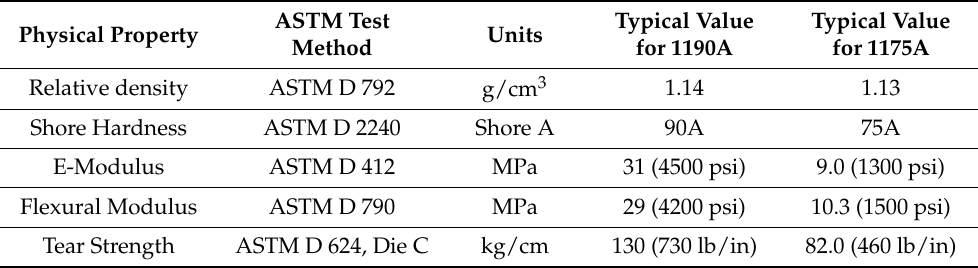
Table 1. A list of selected physical properties provided by the Basf ® manufacturer for the 1190A and 1175AW TPU Elastollan ® measured on injection-molded samples.